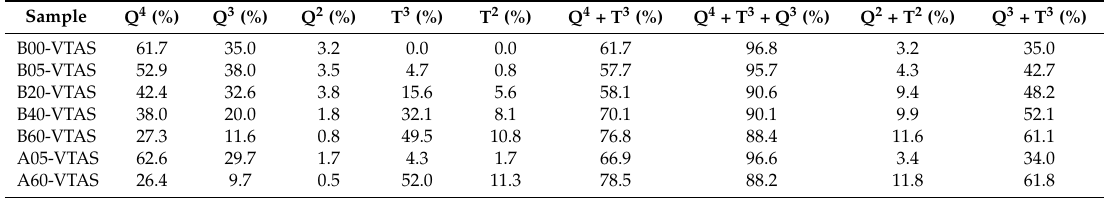
Figure 8. 29 Si MAS NMR spectra of vinyl substituted silica xerogels. Table 4. The results obtained from the quantification of the 29 Si CP-MAS NMR